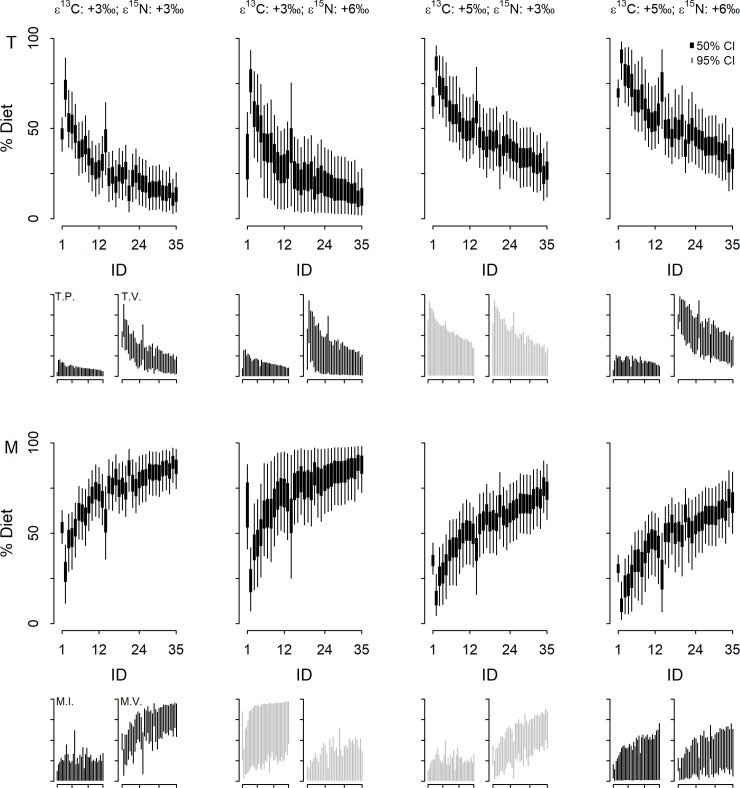
Contributions of food groups to diets of Later Stone Age humans on the Cape Peninsula.Plots in each column correspond to those in the first column labelled according to food type. Line segments in larger graphs denote credible intervals as indicated in the legend (top-right), generated using Bayesian stable isotope mixing models. Smaller graphs show only 95% CI on the same sets of axes as those in larger graphs. Grey line segments indicate that foods in that row were indistinguishable for that model. ID numbers identify individual humans, arranged in order of δ13C values–increasing from left to right. T = terrestrial foods, T.P. = terrestrial plant foods, T.V. = terrestrial vertebrate foods, M = marine foods, M.I. = marine invertebrate foods and M.V. = marine vertebrate foods.